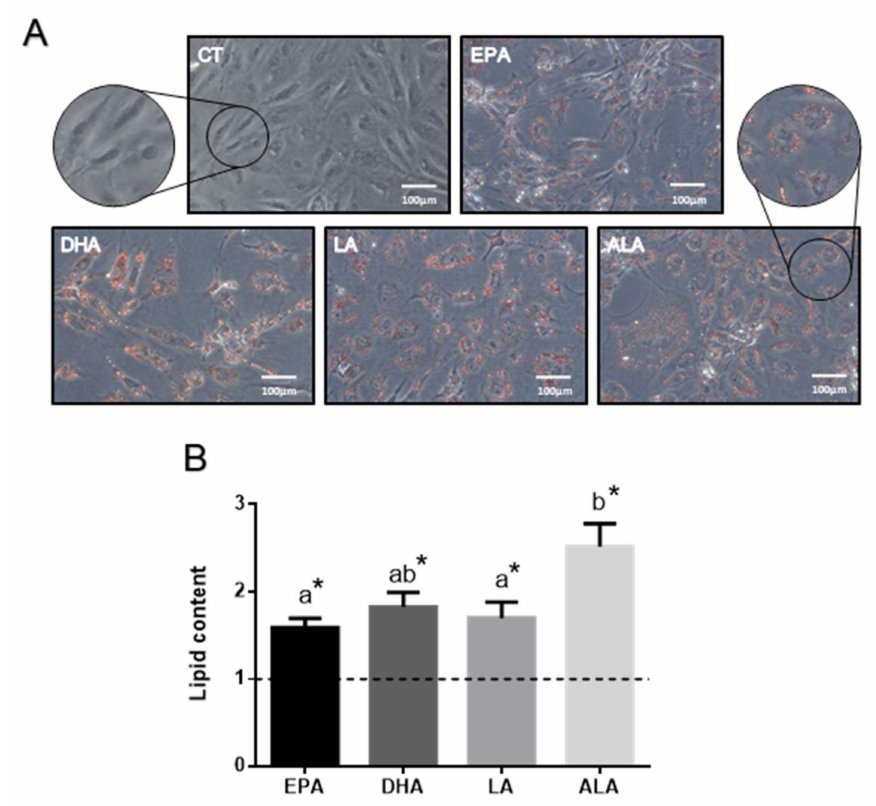
Figure1. ( A )Representativephase-contrastimages(and2 × enlargements)ofrainbowtroutpreadipocyte cells after staining with Oil red O and ( B ) quantification of lipid content. Cells were treated at day 7 with individual fatty acids (100 µ M) or were left untreated as control (dashed line in (B) for 48 h. Data are shown as mean + SEM ( n = 4). Significant di ff erences ( p < 0.05) with the control are indicated by asterisks (*) and among treatments by di ff erent letters (a,b). CT: control; EPA: eicosapentaenoic acid; DHA: docosahexaenoic acid; LA: linoleic acid; ALA: α -linolenic